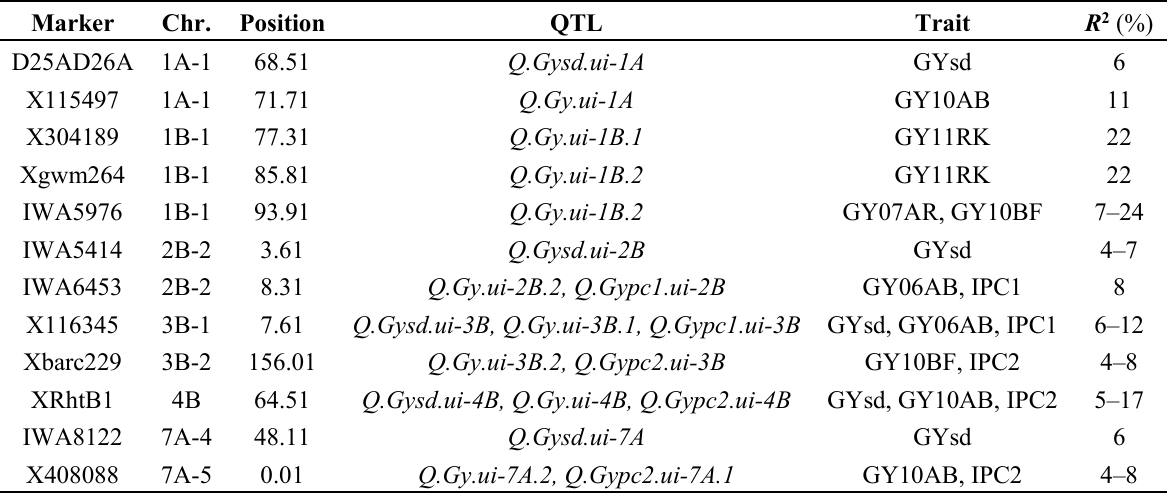
Table 6. QTL showing significant QTL × environment interaction effect for grain yield. Marker